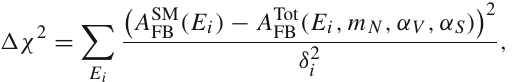
(cid:2)γ to the effective couplings FB